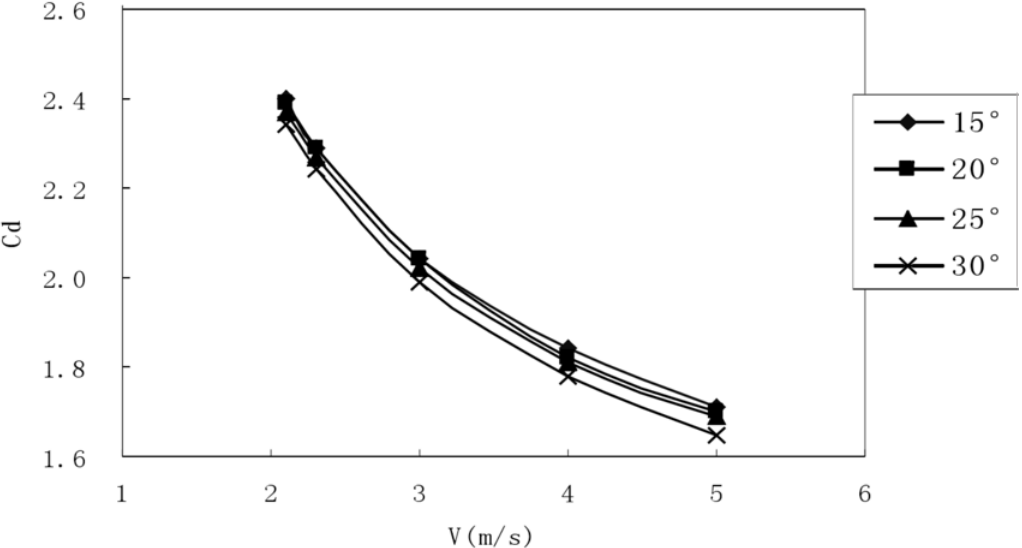
Figure 4. Resistance coefficients corresponding to different finger opening angles (opening angle: 90°). The abscissa is the swimmer’s speed (v), and the ordinate is its resistance coefficient ( C d ). The angle marked in the legend is the palm’s angle of attack.